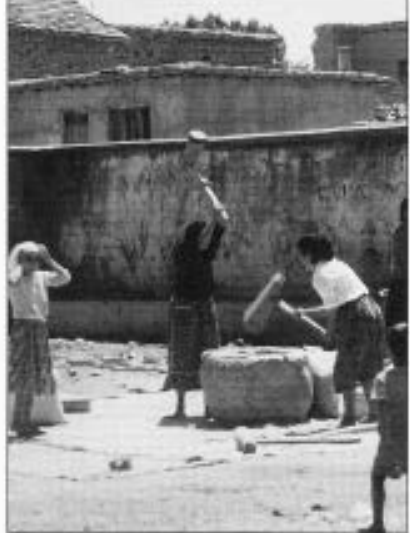
Figure 3 Women in a Turkish village de­ branning grain for bulghur using a large stone mortar and wooden mallets,